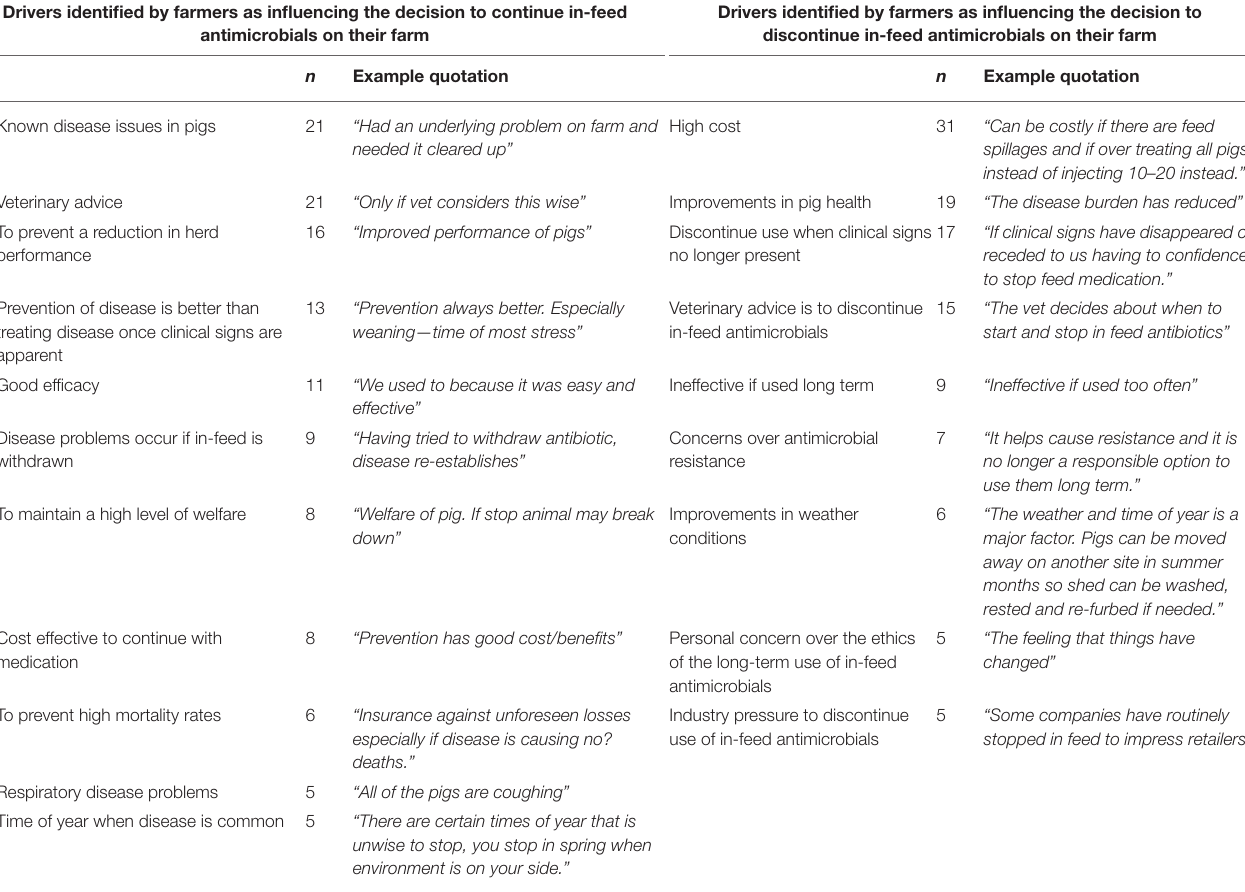
TABLE 6 | Themes volunteered by questionnaire respondents as influencing the decision to continue or discontinue in-feed antimicrobials on their farm. Drivers identified by farmers as influencing the decision to continue in-feed Drivers identified by farmers as influencing the decision to antimicrobials on their farm discontinue in-feed antimicrobials on their